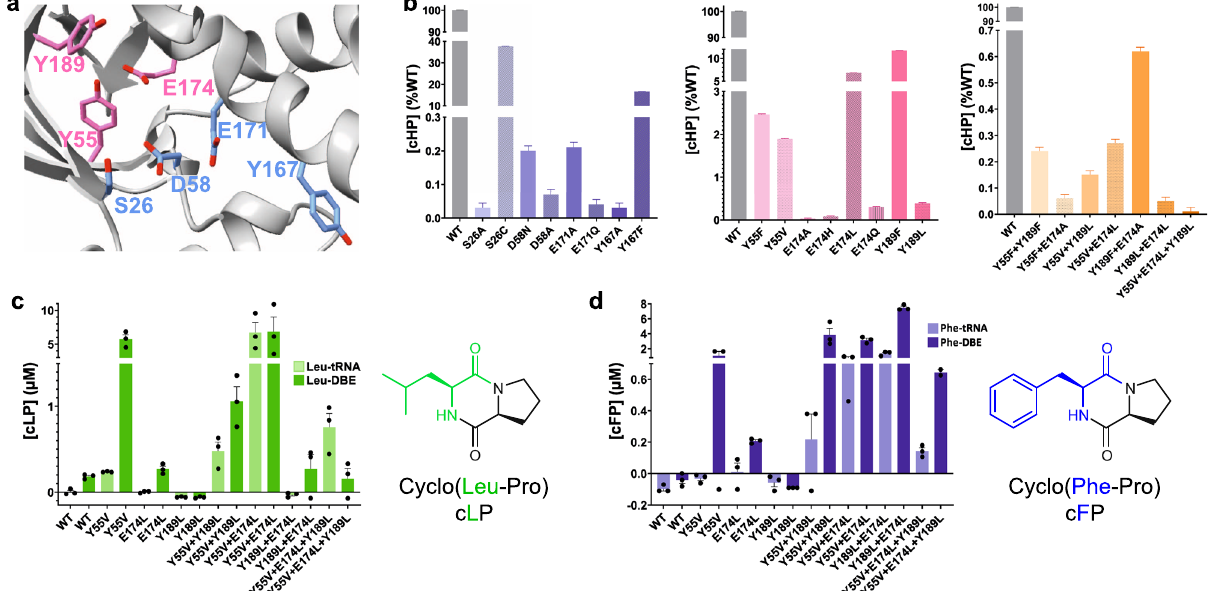
Fig. 5 Rational engineering of Parcu CDPS P1. a enhanced image of the WT structure highlighting the two sets of residues targeted for mutagenesis – active site (blue) and pocket 1 (pink). b cHP activity assay for each set of mutants using the tRNA pool and puri fi ed aaRSs mentioned previously. The activity is shown as a percentage of the wild-type Parcu CDPS activity, and errors were propagated accordingly to account for errors in each parameter individually. Each residue is shown in a different colour and the patterned bar represents a second mutation of the same residue. The overall trend shown is a decrease in the capability of the mutants to produce cHP with S26C displaying the overall highest yield. c Quanti fi cation of cyclo(Leu-Pro) production using Parcu CDPS variants; Pro-tRNA was used in combination with Leu-tRNA and Leu-DBE to investigate the use of different substrates on product yield. d Quanti fi cation of cyclo(Phe-Pro) using the same mutants as tested for cLP. Data is shown on panels b , c and d as the individual points + standard error of the mean (SEM) of experiments conducted in triplicate, measurements were taken from distinct samples, and authentic commercial standards were used for calibration curves and quanti fi